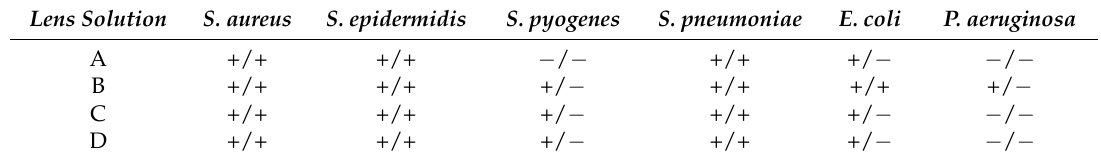
Table 4. Efficacy of the contact lens solutions against biofilm at different temperatures (37 ◦ C/ 25 ◦ C). Lens